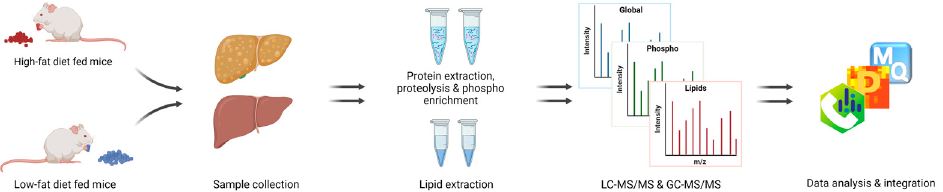
Figure 2. Workflow. Fatty liver establishment by HFD, followed by proteomic, phosphoproteomic, and lipidomic analysis.